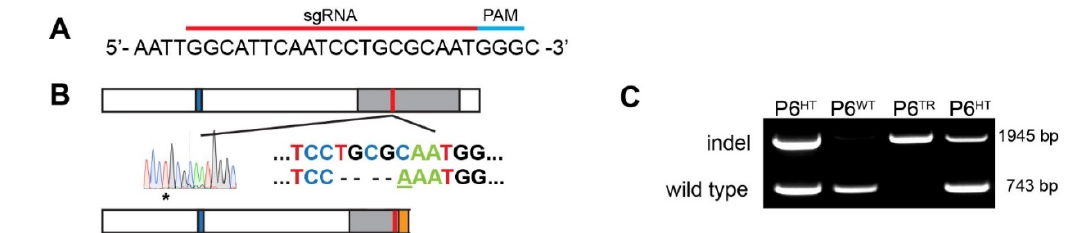
Figure 1. Identification of CRISPR/Cas9-mediated genome modification of Parp6 in mice by sequencing and genotyping analysis. ( A ) sgRNA target site (red) followed by the PAM sequence (blue) in the Parp6 gene. ( B ) Schematic representation of the domain structure of Parp6 WT : additional sequence found in neuronal cells (blue box), catalytic domain (gray box), sgRNA target site and CRISPR-derived changes ( Δ 5bp del + 1bp insert, red box), and frameshift mutation leading to changed residues and an early stop codon (orange box) resulting in a truncated Parp6 (Parp6 TR ). ( C ) Mouse genotyping shows upper 1495 bp band representing the indel allele (Parp6 TR ), and lower 743 bd band representing the wild-type Parp6 WT allele. Parp6 HT (heterozygous) shows both